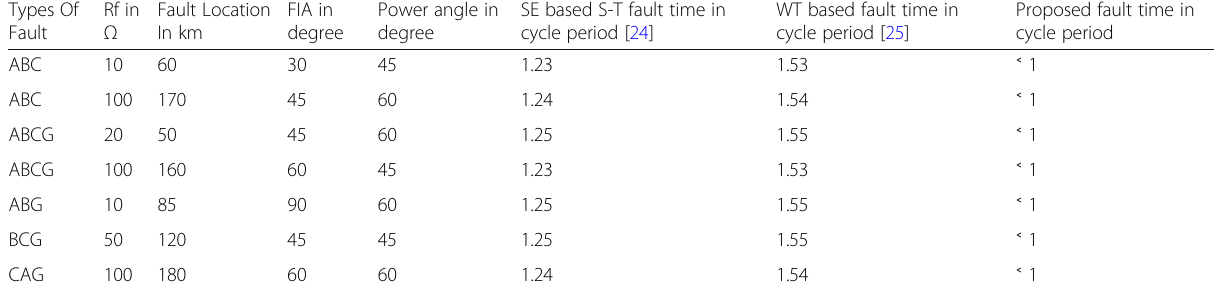
Table 2 Performance of fault detection, fault time at Rf value of different location in line Types Of Fault